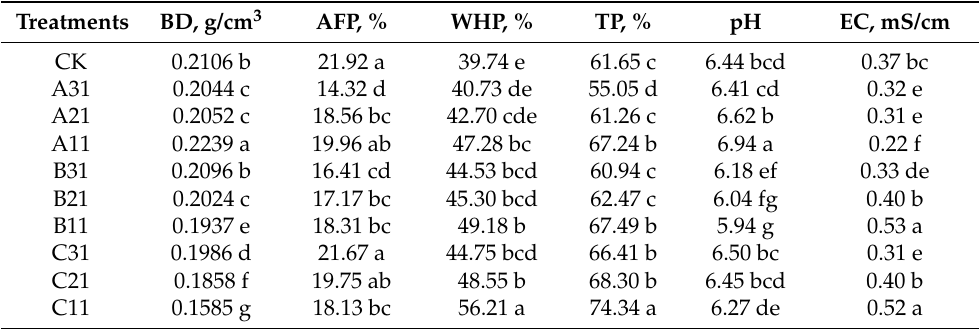
Table 1. Physicochemical properties of substrates treated with different additions.